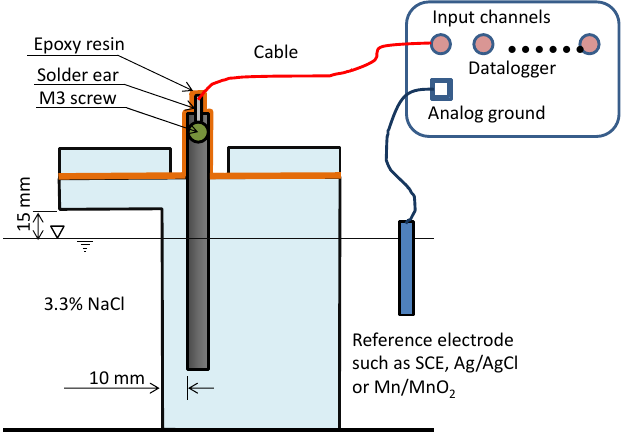
Figure 2. Illustration of a cut concrete specimen exposed to the chloride